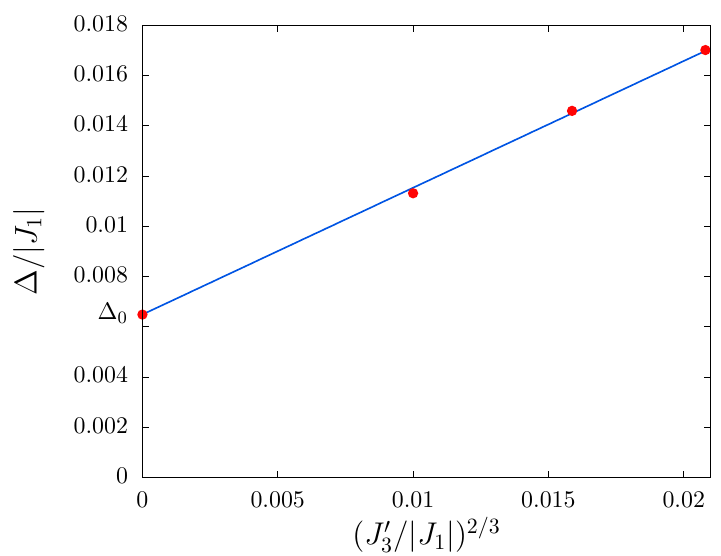
Figure 8: Spin gap ∆ as a function of the third neighbor AFM interaction J (cid:48) α = 0.6. The red line points are data points, the blue line is a linear fitting. We = 0 ) as ∆ indicate ∆ ( J (cid:48) . The fitting function yields ∆ − ∆ 0 3